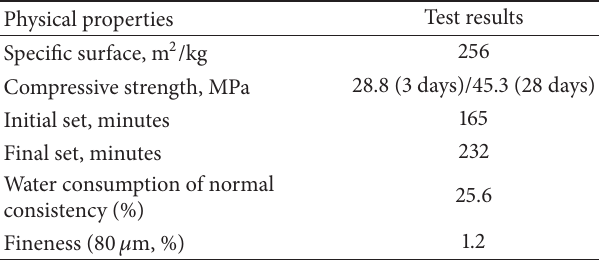
Figure 1: Generated bubbles.